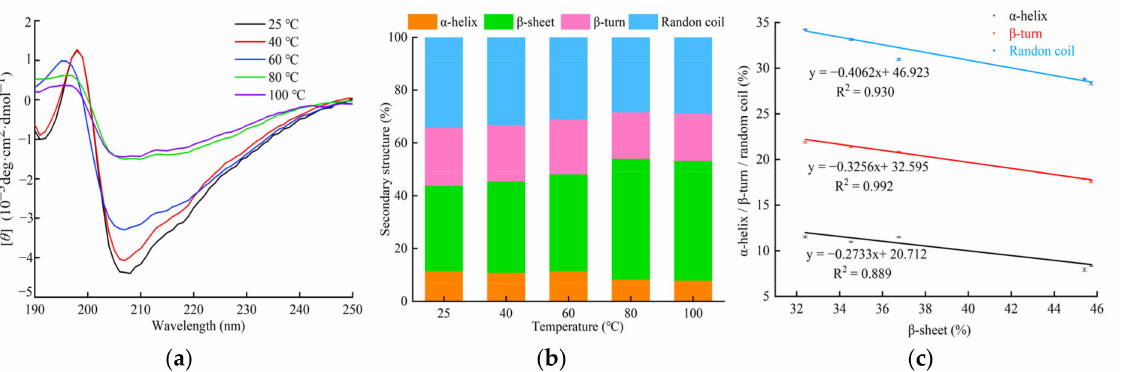
Figure 7. ( a ) CD spectral analysis of F1 heated at different temperatures (25, 40, 60, 80, and 100 ◦ C). ( b ) Changes in the relative content of secondary structural elements of F1 heated at different tempera- tures (25, 40, 60, 80, and 100 ◦ C). ( c ) Content of α -helices, β -turns, and random coils relative to the β -sheet content of F1 heated at different temperatures (25, 40, 60, 80, and 100 ◦ C).